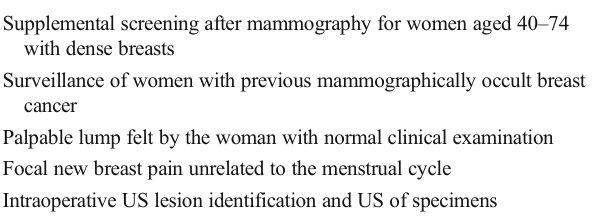
Possible indications for breast ultrasound Supplemental screening after mammography for women aged 40 – 74 with dense breasts